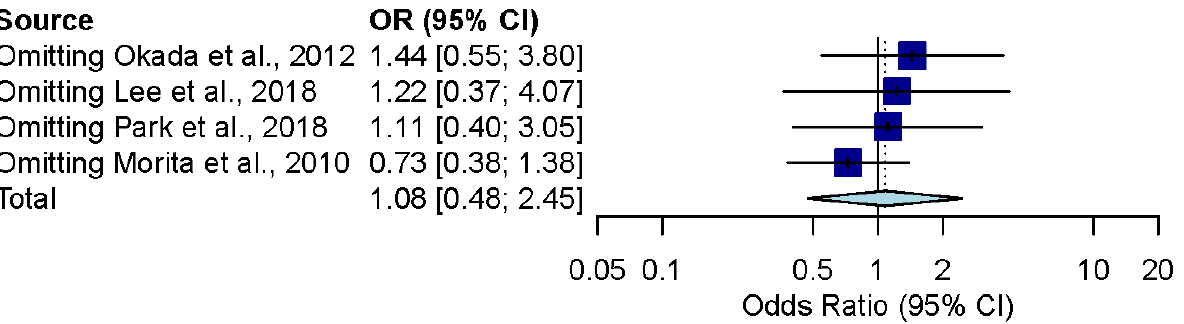
Figure 4. Influence analysis for the overall effect of steroid and combination therapy in ALHL patients [9–11,20].